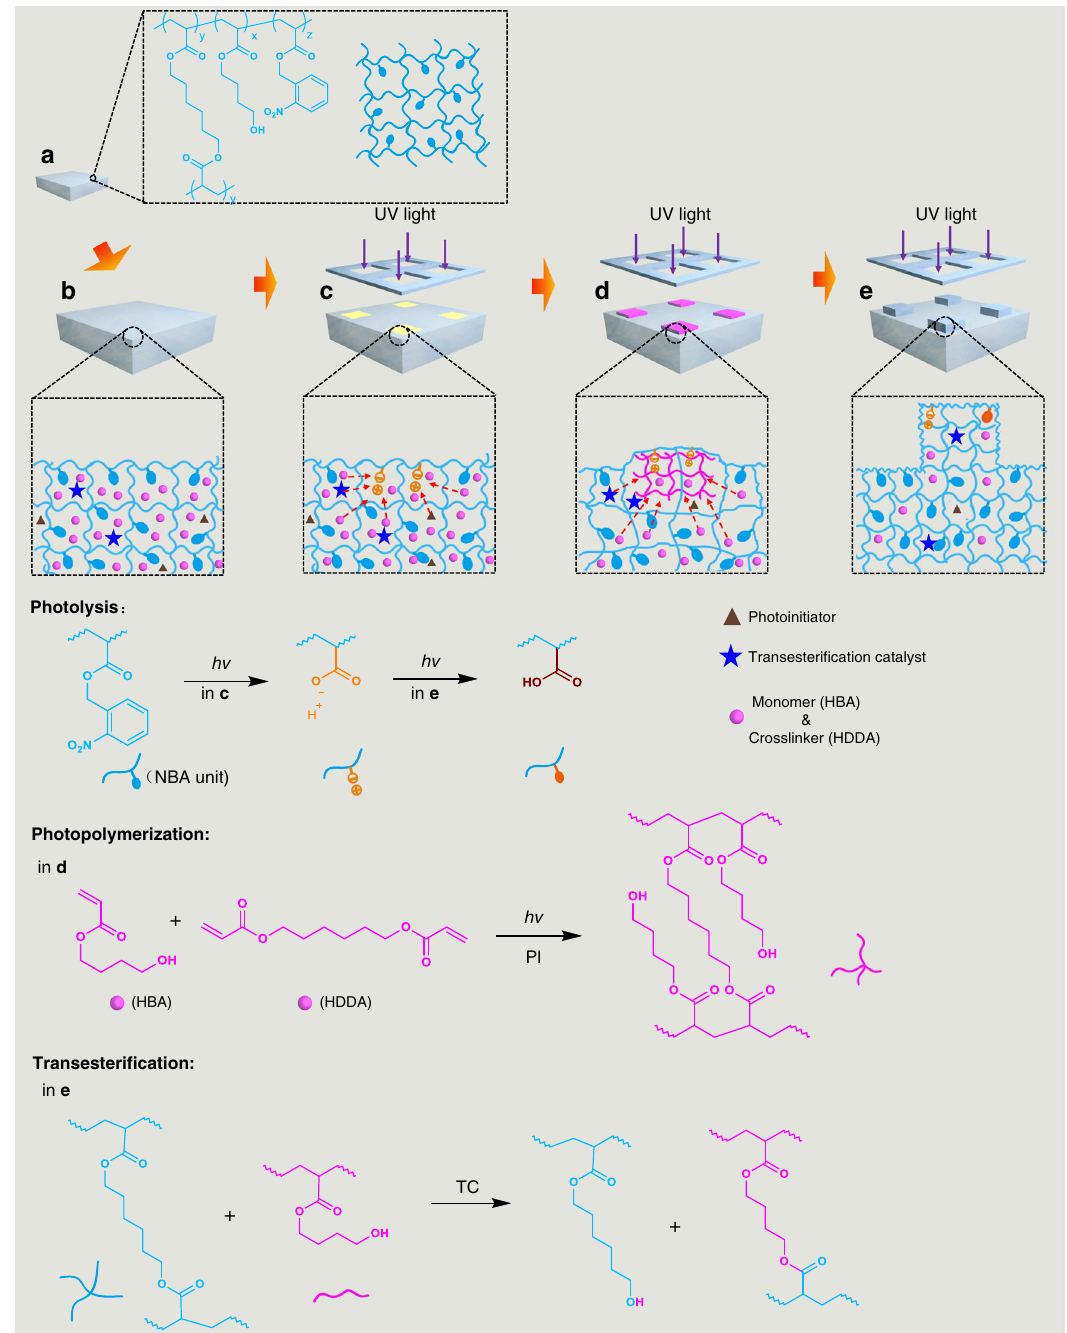
Fig. 1 Schematic of light-induced growth from swollen substrates. a Growable seed made from 4-hydroxybutyl acrylate (HBA), o -nitrobenzyl acrylate (NBA, promoter), Irgacure 819 (I-819, photoinitiator) and 1,6-hexanediol diacrylate (HDDA). b Swollen seed. The mixture of HBA, HDDA, photoinitiator (I- 819), and transesteri fi cation catalyst (benzensulfonic acid (BZSA)) were used as the nutrient solution for swelling. c Swollen substrate under selective UV irradiation. Photolysis of NBA units generated dissociable ionic groups to induce liquid diffusion into the irradiated region. d New polymer network formed via photopolymerization. Liquid components diffused in, and the polymer chains in the original network were stretched. e The grown part was homogenized via transesteri fi cation reactions between the original and newly formed polymer Light-triggered localized growth . Figure 2a shows an image of Figure 2b shows the growth process evaluated by the height light-induced growth of a pillar from the surface of a fl at swollen of the grown pillar. The growth process of swollen seed-20% seed-20%. During UV irradiation, a regular structure slowly grew was triggered by irradiation with either 365 nm or 460 nm light. out from the irradiated region of the material surface, and the height of this pillar could reach up to 250 μ m during the testing time.